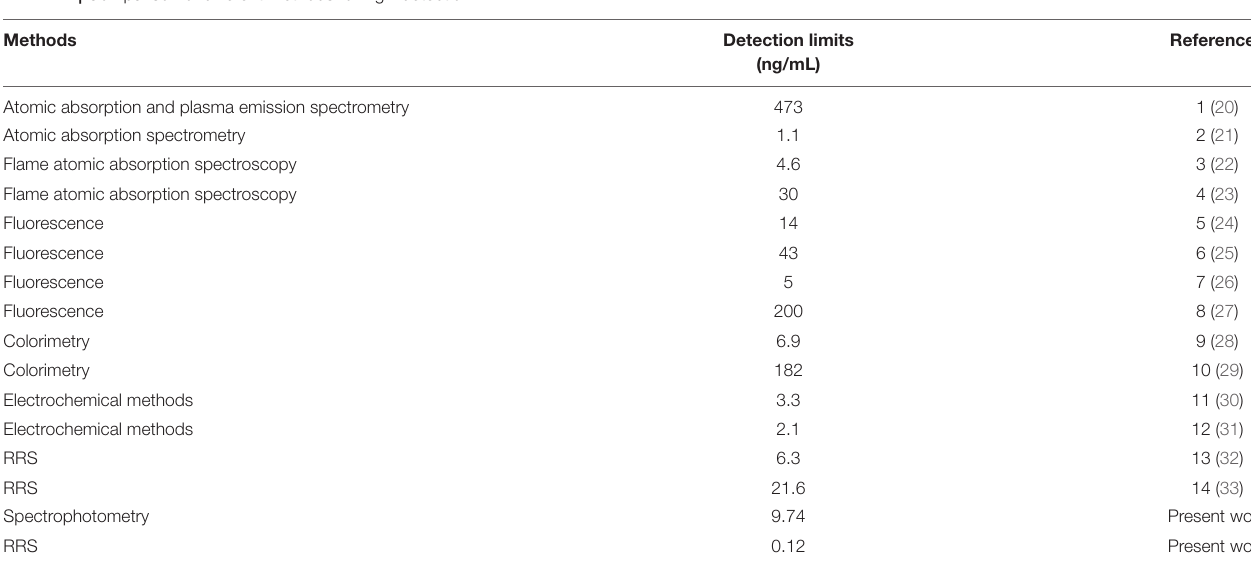
TABLE 2 | Comparison of different methods for Ag + detection.